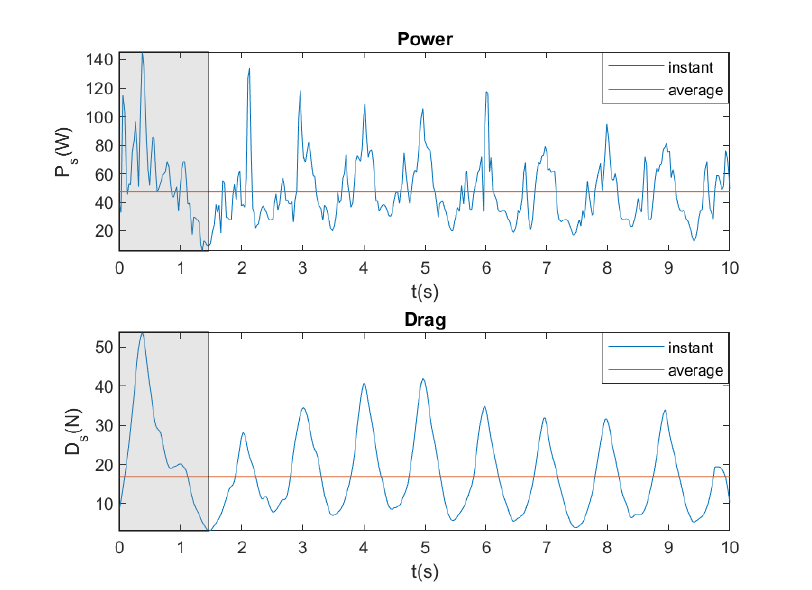
Figure 13. Instantaneous and average power and drag. Breaststroke. Brake force = 81.58 N.